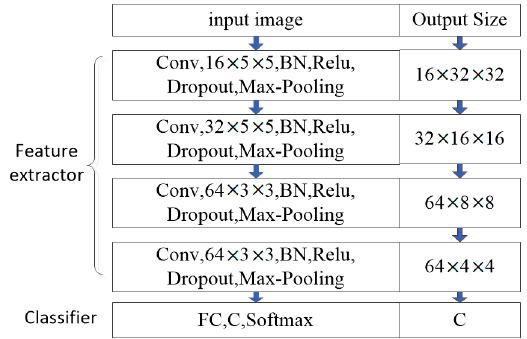
Figure 3. The network configuration of our model.